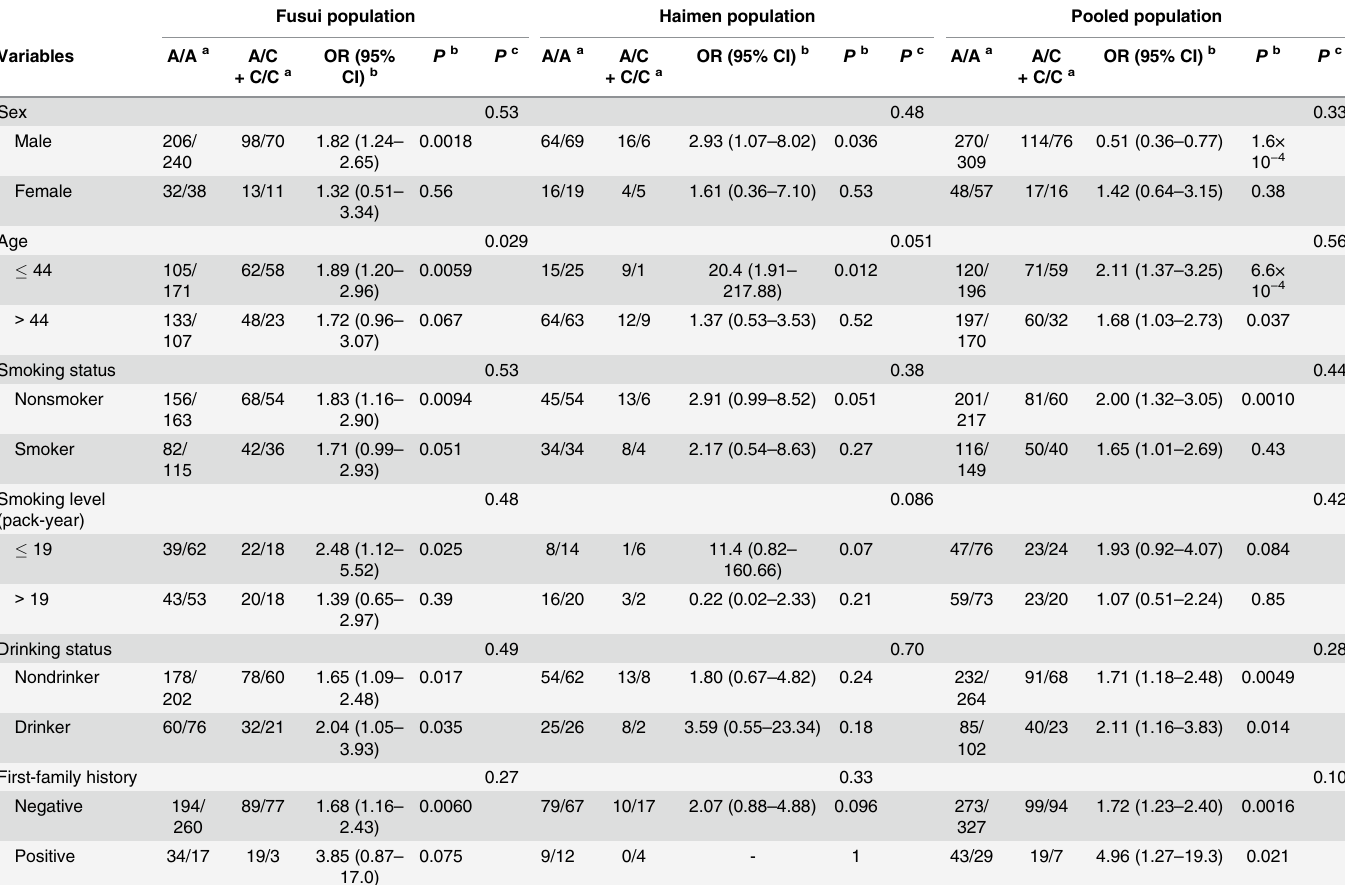
Table 3. Risk of hepatocellular carcinoma associated with rs3771333 by potential risk factors in the Fusui, the Haimen and the pooled